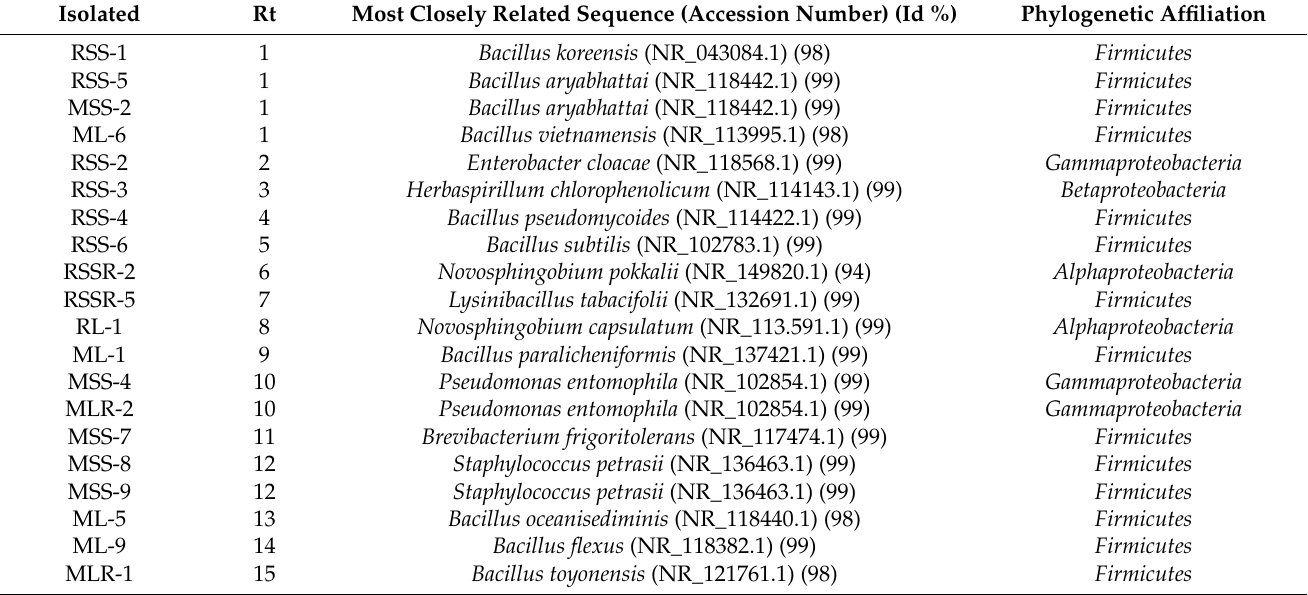
Table 6. Identities of bacterial strains isolated from hydroponic system in M. spicata and R. officinalis plants. Isolated Rt Most Closely Related Sequence (Accession Number) (Id